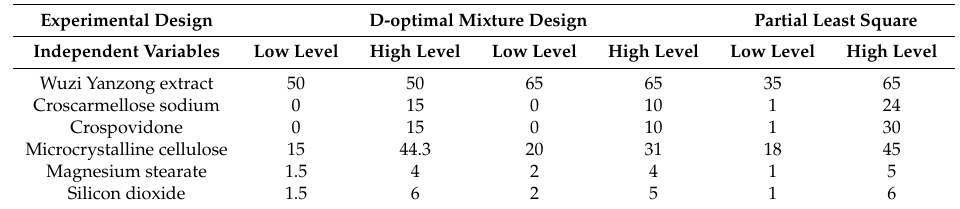
Table 1. Independent variables (percent composition of ingredients) of the experimental designs for Wuzi Yanzong extract tablet